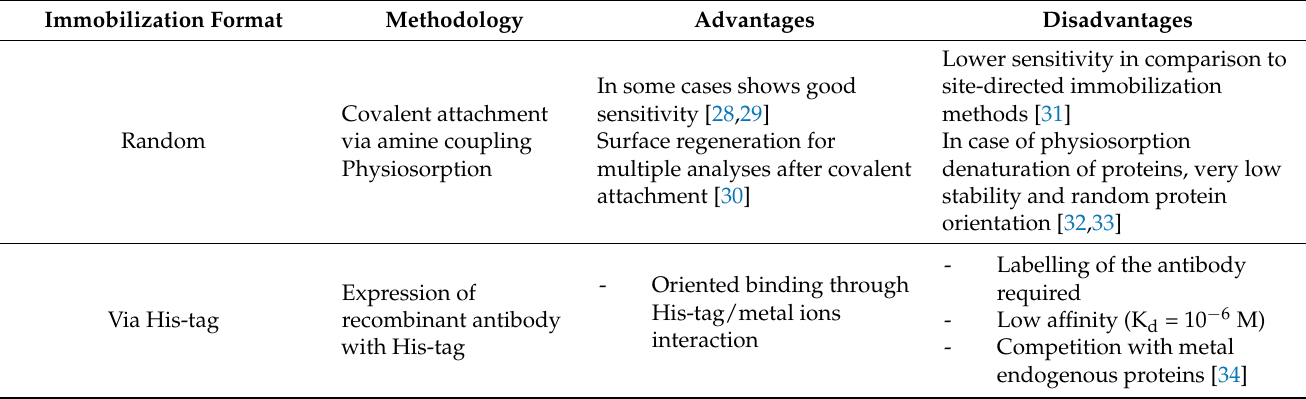
Table 1. Comparison of different site-directed and random antibody immobilization techniques, table adapted from Makaraviciute et al. Reprinted with permission from Ref. [27]. Copyright 2013 Elsevier.